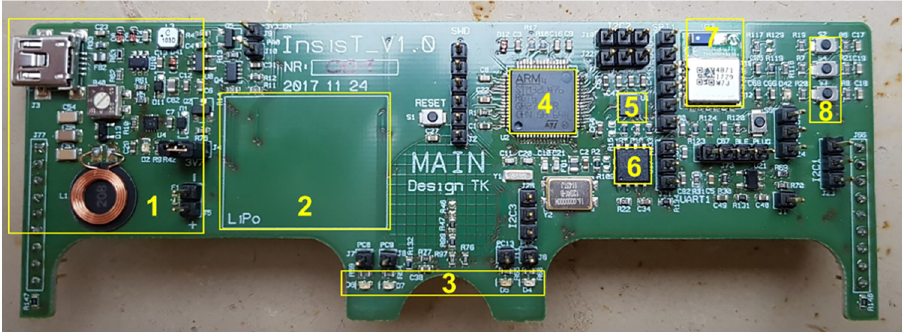
Fig 3. Photograph of electronic glasses frame. (1) Wireless charging and USB interface, (2) space for lithium- polymer battery, (3) feedback LEDs, (4) microcontroller, (5) accelerometer, (6) Flash memory, (7) Bluetooth low energy module, and (8) three push